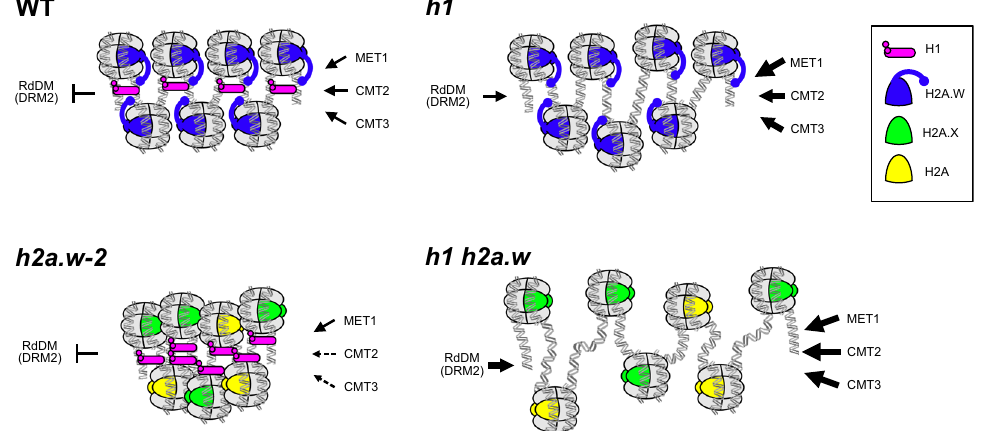
Fig. 9 Model of co-regulation of heterochromatin accessibility by H2A.W and H1. In WT, H2A.W and H1 both interact with heterochromatin linker DNA to maintain a normal balance of accessibility to chromatin modi fi ers and DNA methyltransferases in heterochromatin. In the absence of H2A.W, H1 over- accumulates at linker DNA and further reduces accessibility. Loss of H1 alone causes incomplete decompaction, while loss of both H1 and H2A.W causes strong decompaction and increased accessibility. Thus, H2A.W promotes chromatin compaction in the absence of H1, but also promotes heterochromatin ‘ breathing ’ by opposing excessive H1 incorporation. The thickness of the arrows illustrates the accessibility of MET1, CMT2, CMT3, and DRM2 to DNA. Dashed arrows represent the lowest accessibility, and for solid arrows, the thicker the arrow, the more accessible the heterochromatic